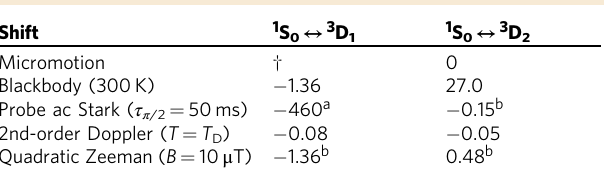
Values are given as 10 − 18 fractional shifts of the respective transition frequencies. Hyper fi ne averaging 9 forbothtransitions,andoperationatrf-trappingfrequency Ω 0 for 3 D 2 areassumed. † dependant on characterization of excess micromotion. T D is the Doppler temperature for the 646nm cooling